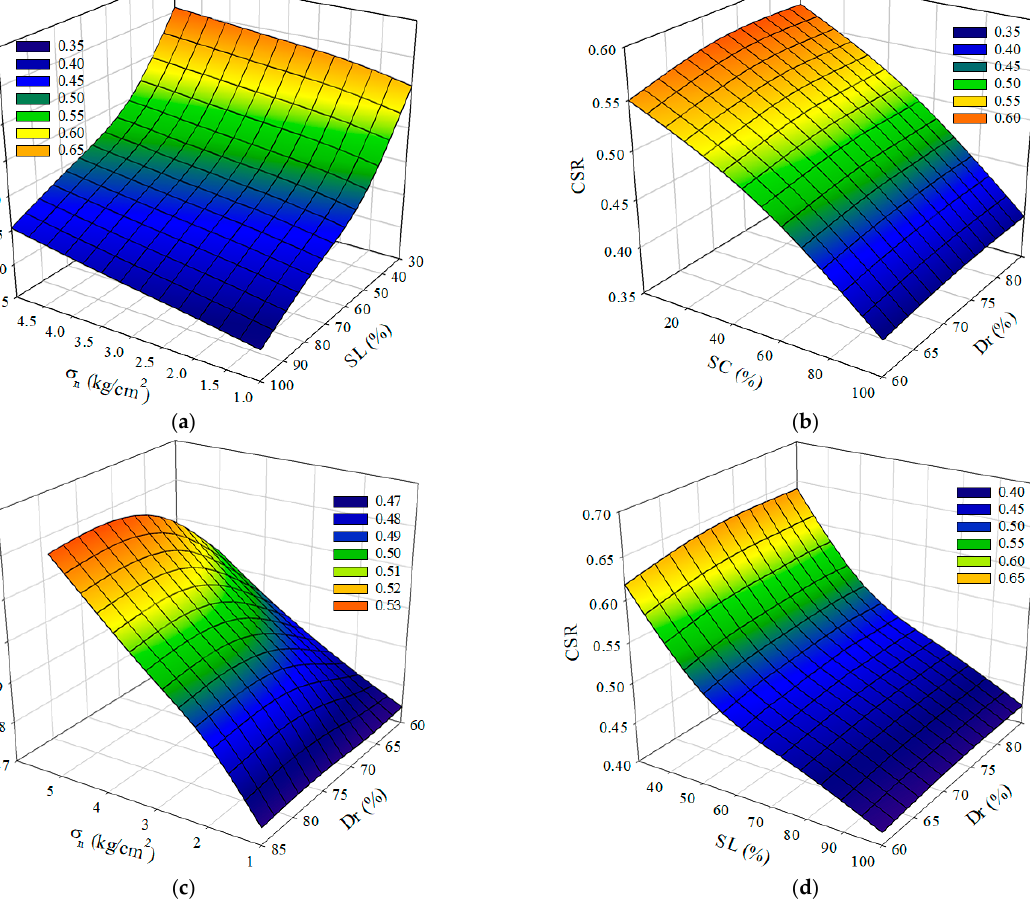
Figure 17. Effect of input parameters on coefficient of stress release. ( a ) interactive effect of σ n and SL, ( b ) interactive effect of Dr and SC, ( c ) interactive effect of σ n and Dr, ( d ) interactive effect of SL and Dr.